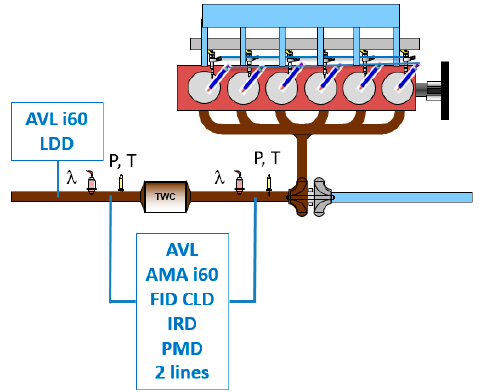
Figure 1. Experimental layout.